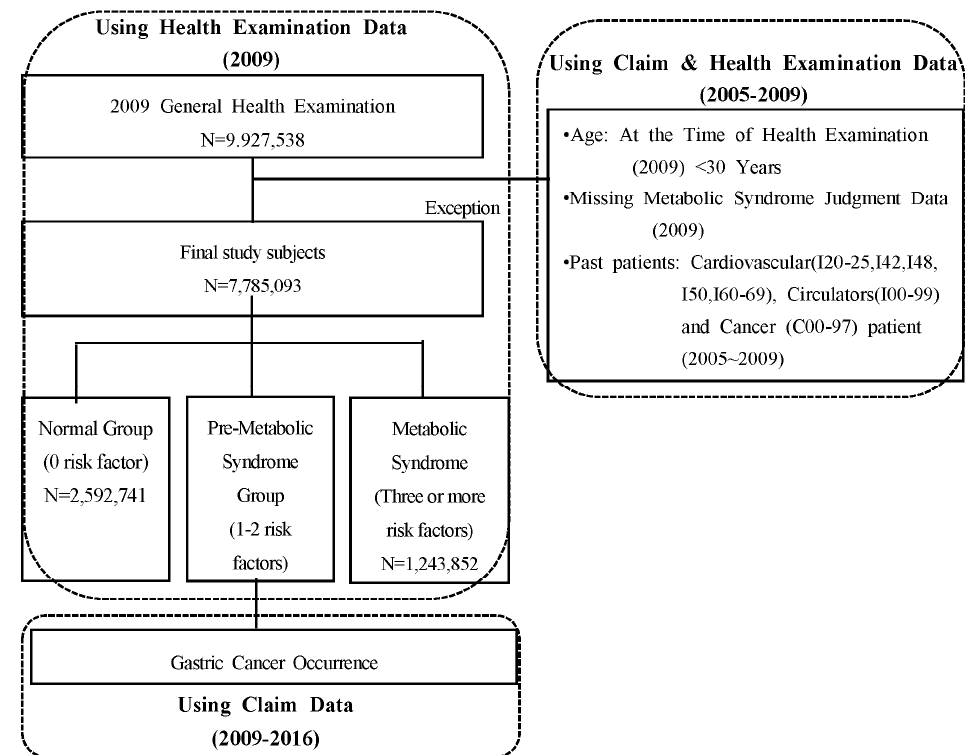
Figure 1. Study design and process of selecting the population.